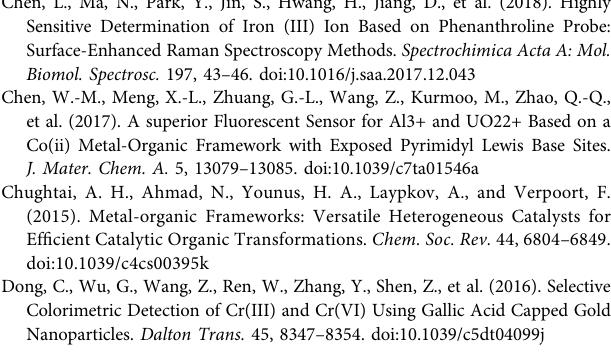
S16 ). Therefore, compound 1 has potential applications as an antibacterial